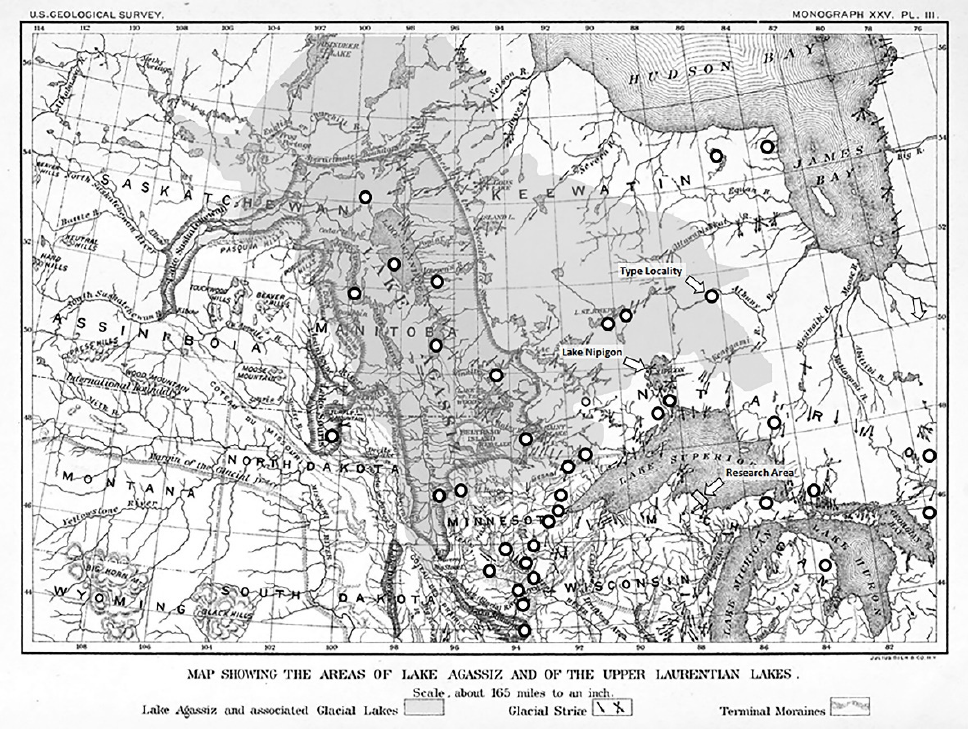
Figure 1. Late Pleistocene glacial geology map showing Lake Agassi and the approximate locations of published collection records from the central part of the range of Hydropsyche alternans. Base map, Plate III from [45]; overlay (gray shading): Lake Agassiz total geographic extent follows Figure 1 from [46]. Collection records from [32,42,47–50]. Additional distribution information from within the boundaries of this map not shown: multiple locations in Lakes Erie, Huron, and Superior [1,3] multiple streams in northern and central Wisconsin [33], multiple streams in northern Michigan [51].